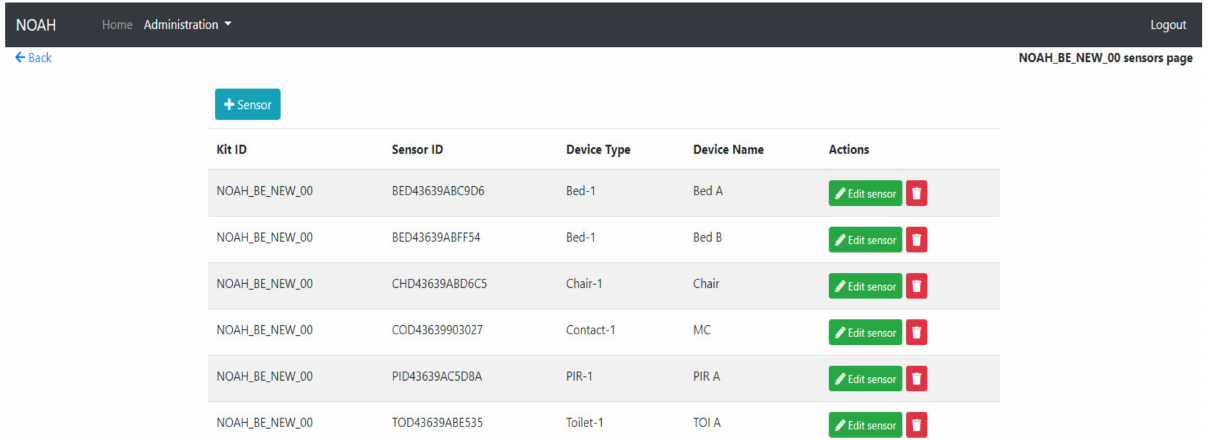
Figure 13. Manage